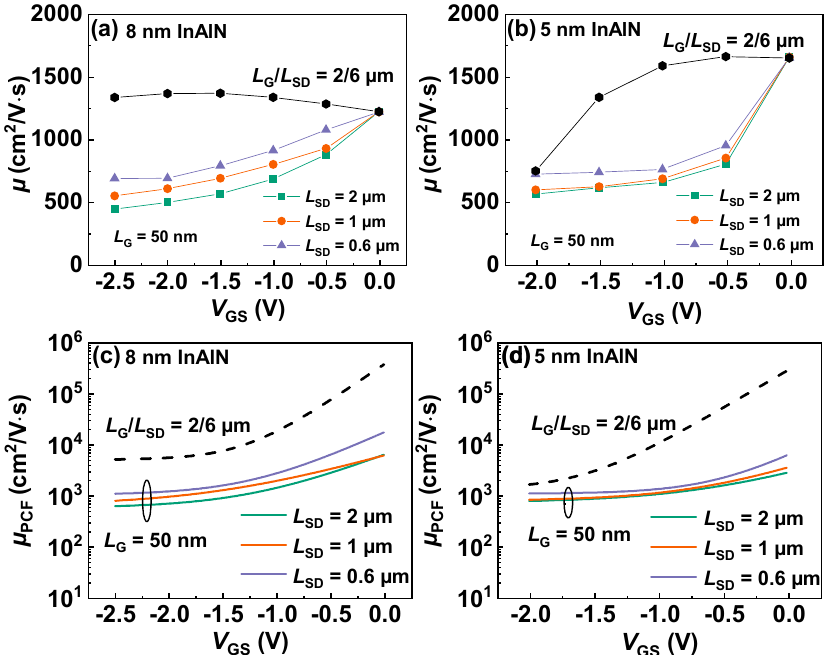
Figure 10. µ versus V GS for the devices with L G of 50 nm and L SD of 2, 1, 0.6 µ m with ( a ) 8 nm and ( b ) 5 nm InAlN. The device with L G / L SD of 2/6 µ m is also plotted for comparison. Calculated µ PCF versus V GS of the same devices with ( c ) 8 nm and ( d ) 5 nm InAlN. The device with L G / L SD of 2/6 μ m is also plotted for comparison.